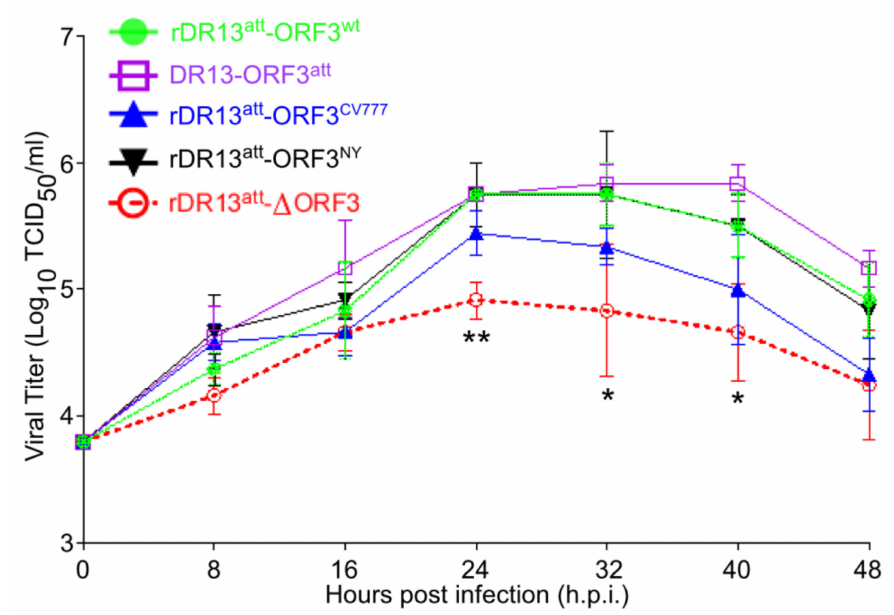
Figure 3. Multi-step growth kinetics of rPEDVs and PEDV DR13 att in Vero cells. Vero cells were infected with rDR13 att -ORF3 wt , rDR13 att -ORF3 CV777 , rDR13 att -ORF3 NY , rDR13 att - ∆ ORF3, and DR13 att at a MOI of 0.1. At the indicated times post-infection, cells and culture media were harvested by three rounds of freezing and thawing, followed by centrifugation to remove cell debris. Supernatants were collected and used to measure viral titers. Results were expressed as the mean values from three parallel tests and error bars represent standard deviations (SD). Symbols * and ** indicate the di ff erence between rDR13 att - ∆ ORF3 and the other viruses was significant ( p < 0.05) or very significant ( p < 0.01),